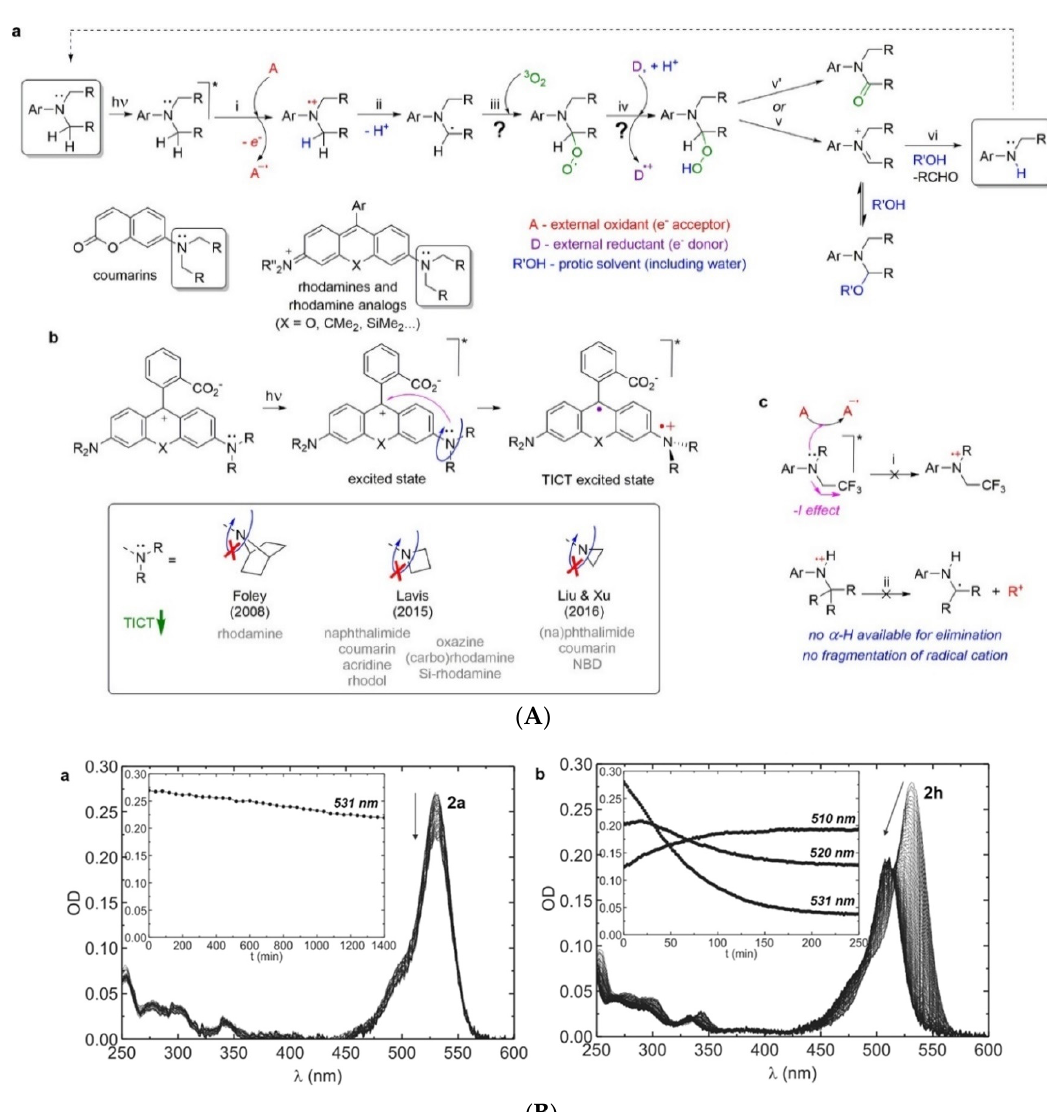
Figure 25. Strategies to reduce photobluing: ( A ) ( a ) General oxidative photobluing pathway for fluorescent dyes with (di)alkylamino auxochromic groups; ( b ) Strategies aimed at suppression of transitioning into the twisted intramolecular charge transfer (TICT) excited state for select classes of fluorophores; ( c ) Possible approaches to mitigate the dye photobluing unrelated to TICT suppression; ( B ) Stepwise Time-resolved absorption spectroscopy experiment demonstrating photolysis of ( a ) a photooxidation-resistant, nonbluing fluorophore in comparison with ( b ) a photooxidation-prone fluorophore. Adapted with permission from [291]. Further permissions related to the material excerpted should be directed to the ACS.